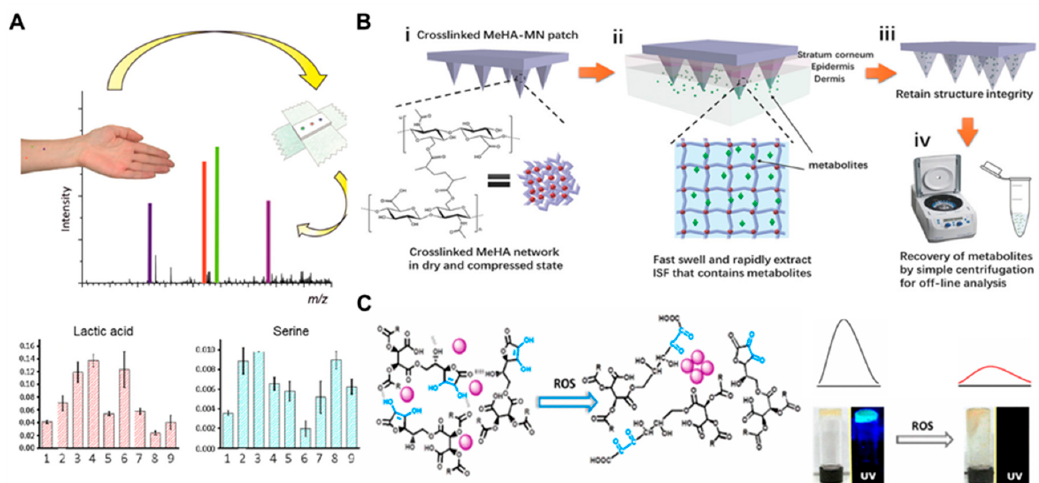
Figure 5 . Hydrogel-based platforms for the detection of skin metabolites and reactive species. ( A ) Agarose micropatch enables collection of secreted sweat within 10 min for subsequent analysis of skin metabolites (lactic acid, serine, etc.) through electrospray ionization mass spectrometry. Reproduced with permission from [45] . Copyright © 2014 American Chemical Society. ( B ) Cross-linked MeHA MNs facilitates rapid extraction of ISF (>1 μ L within 1 min) for offline recovery and analysis of skin metabolites including glucose and cholesterol. Reproduced with permission from [61] . Copyright © 2017 John Wiley and Sons. ( C ) Reactive oxygen species (ROS) sensor based on ascorbic acid hydrogel encapsulating luminescent carbon-dots. ROS-induced oxidation leads to the collapse of the hydrogel framework, aggregation of carbon dots, and quenching of its luminescence. Reproduced with permission from [115]. Copyright © 2016 American Chemical Society.